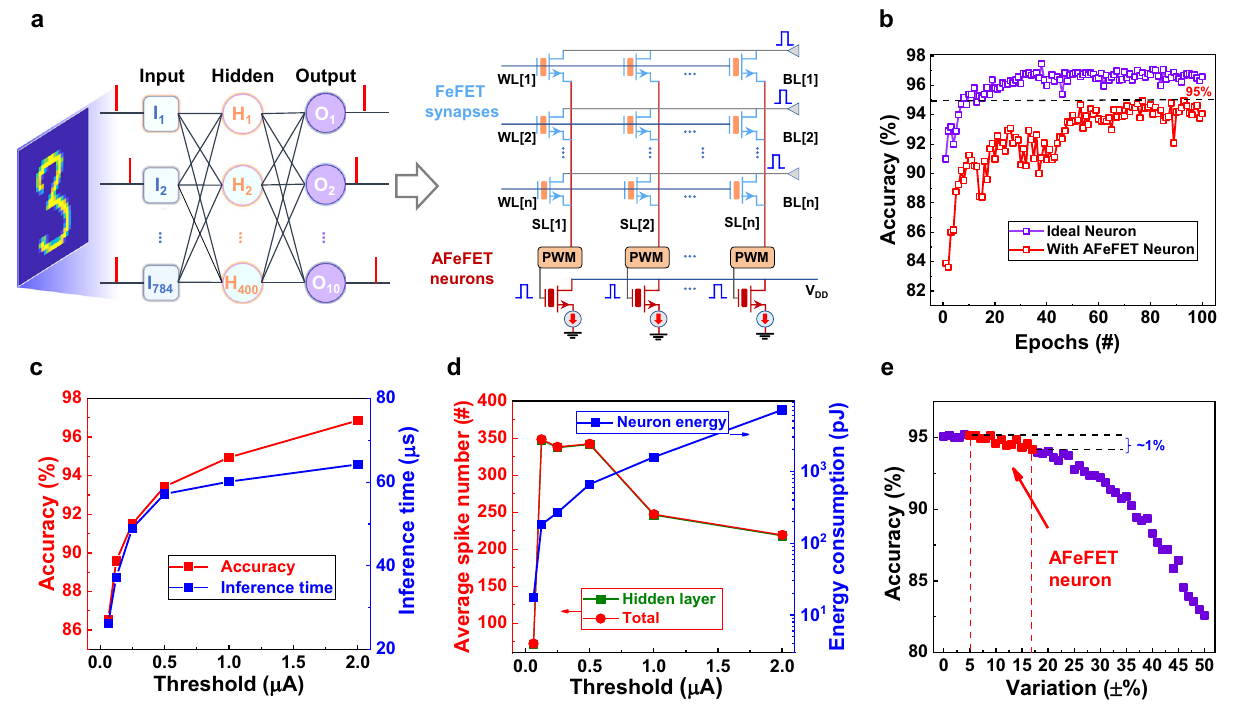
Fig. 4 | Network-level performance of AFeFET neuron. a Schematic of two-layer fully ferroelectric SNN (784×400×10) for classifying MNIST datasets and the proposed hardware implementation of the network based on FeFET synapses and AFeFET neurons. b The inference accuracy as a function of training epochs with ideal LIF neurons and AFeFET neurons, 95% recognition accuracy can be achieved for AFeFET neurons under the 1 μ A threshold. c The speed-accuracy trade-off. The network is trained under different thresholds for all hidden and output neurons,